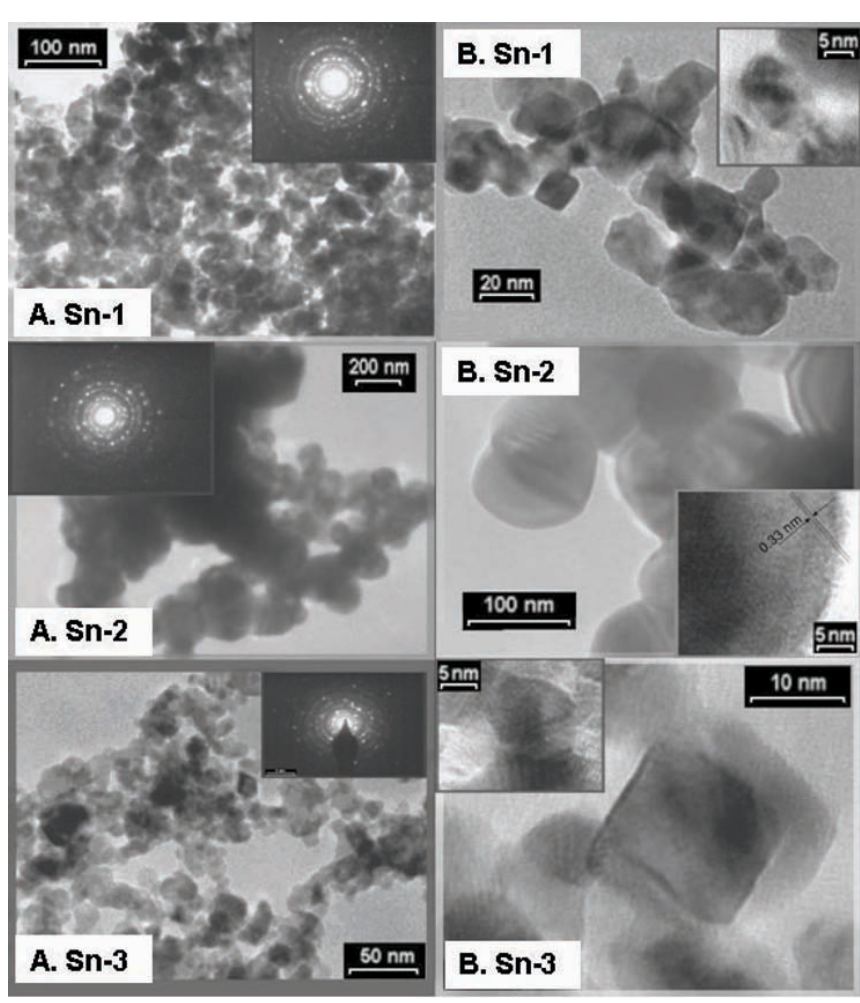
Figure 3. TEM images of SnO nanopowders: (A) TEM images with the SAED pattern and (B) HRTEM 2